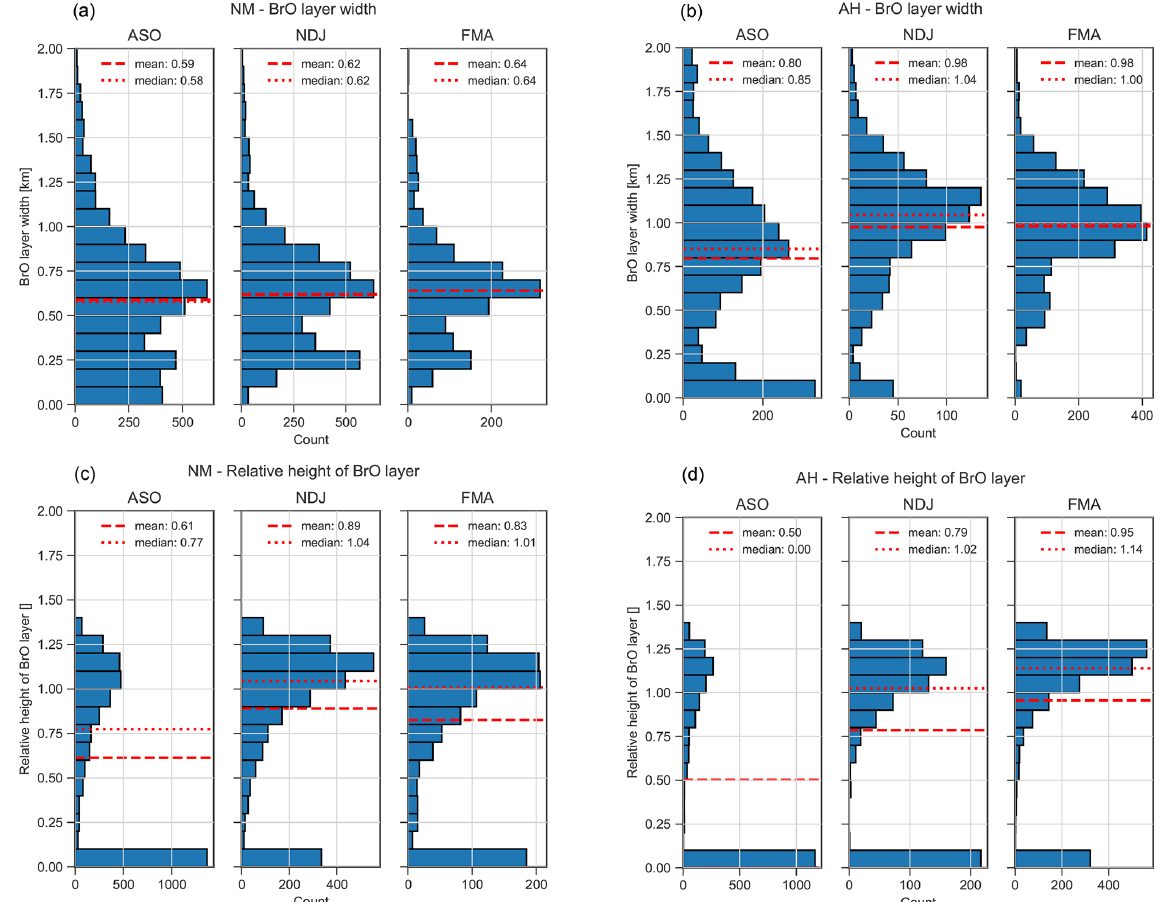
Figure 10. Histograms of BrO layer width w (a, b) and relative layer height ˜ h (c, d) for NM (a, c) and AH (b, d) during ASO, NDJ, and FMA (for a definition of w and ˜ h , see Sect. 3.2). Dashed and dotted horizontal lines indicate mean and median,